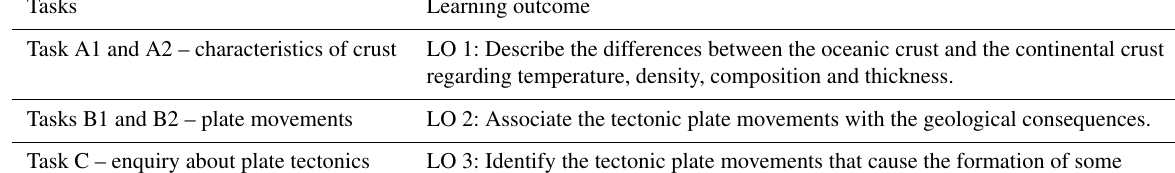
Table 1. Relationship between the educational resource CreativeLab_Sci&Math | Plate Tectonics tasks and the learning outcomes. Tasks